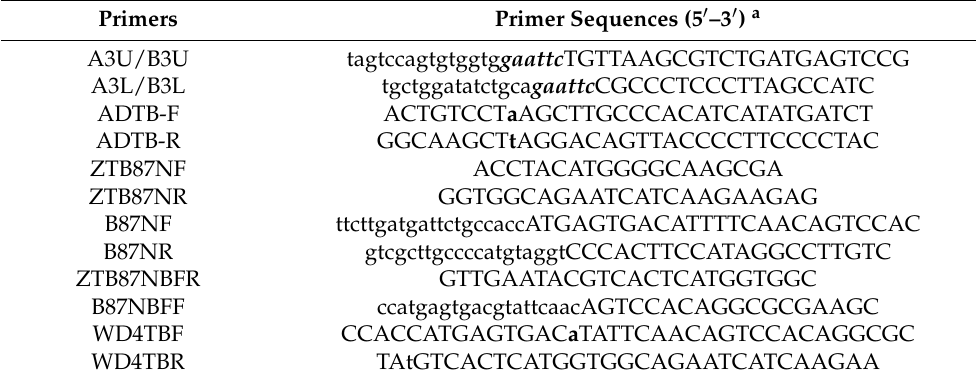
Table 1. The primers used for homologous recombinations and mutations in the genome and construction of mosaic B